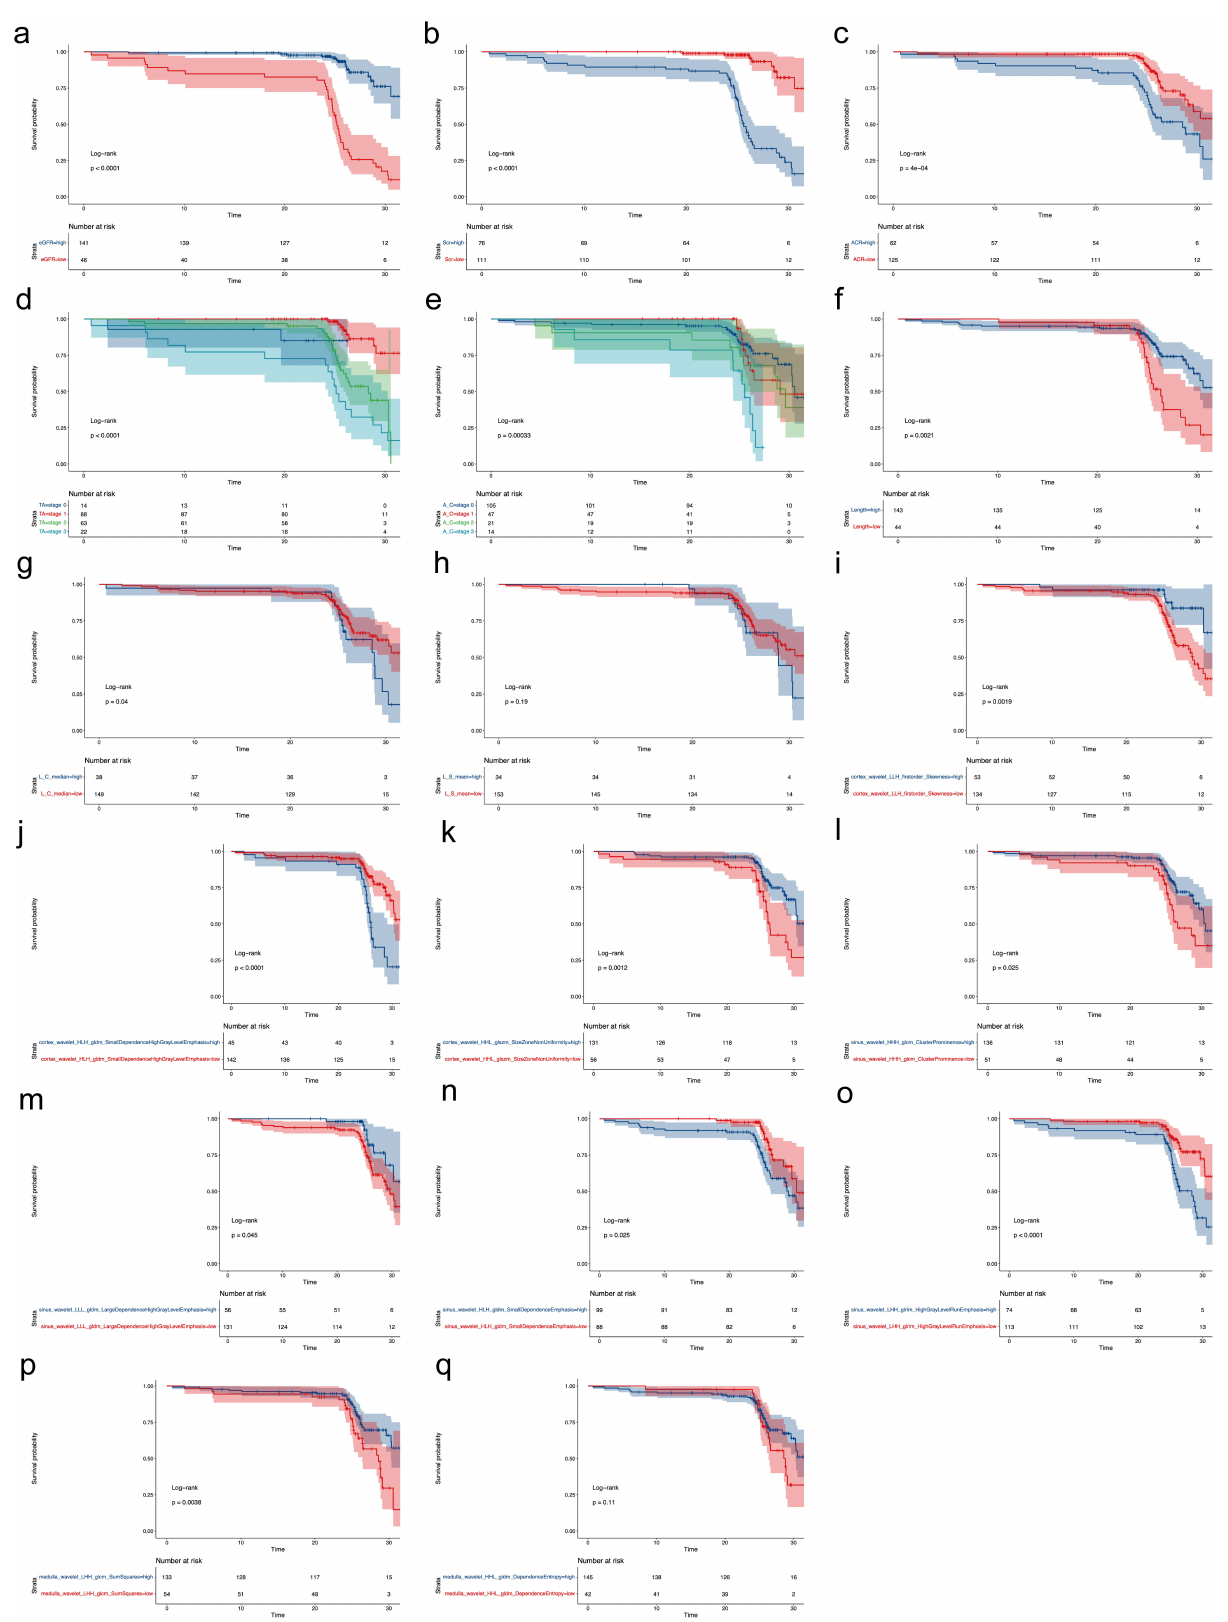
Figure 3. Kaplan–Meier curve for CKD prognosis. The features were divided into a high group or a low group based on their cutoff value. ( a – q ), the Kaplan–Meier curve for CKD prognosis by